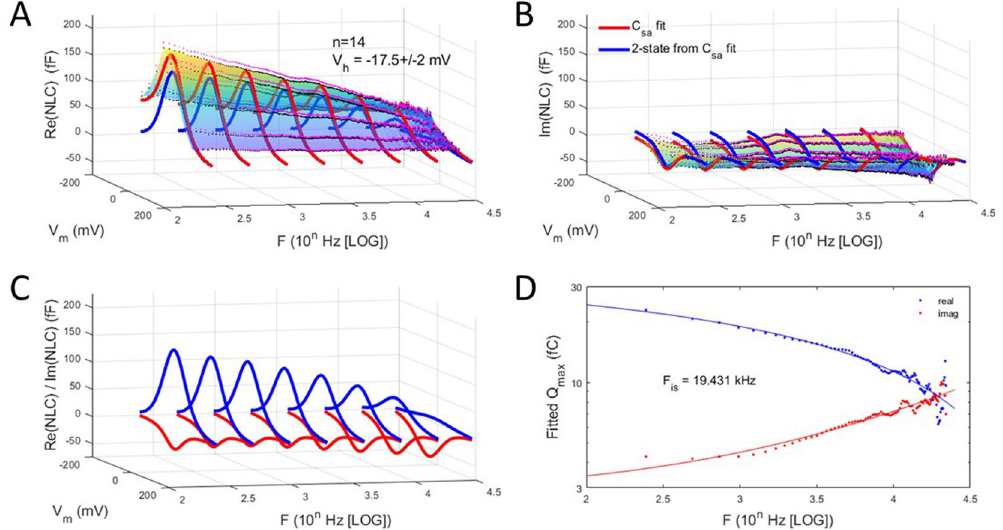
Figure 5. Complex NLC patch data for patches categorized with V h more positive than − 30 mV. (A–C) Again, legends to Fig. 1A–C analogously apply here. (D) Plot of fitted Q max of 2-state components of complex NLC. The real and imaginary component magnitudes intersect at a particular frequency, F is . Here the imaginary component absolute magnitude is plotted. Fits (solid lines) are with Eq. (2). Red is real component; blue is imaginary component. F is is 19.4